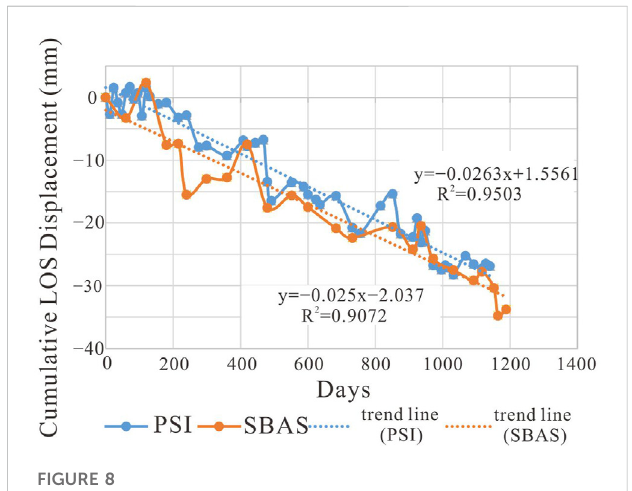
FIGURE 9 Cumulative LOS displacement of zone “ b ” (SBAS